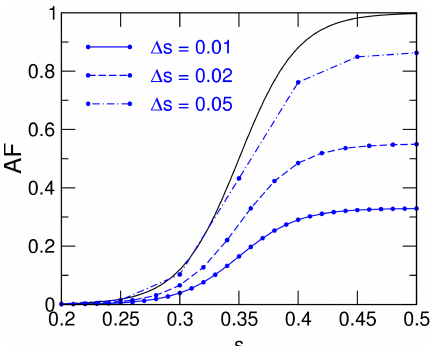
Figure 2. The cumulative AF ( φ , black curve) and associated differ- ential AFs ( ϕ , blue curves) evaluated across three s -grids with con- stant spacings: (cid:49)s = 0 . 01 (solid), (cid:49)s = 0 . 02 (dashed), and (cid:49)s = 0 . 05